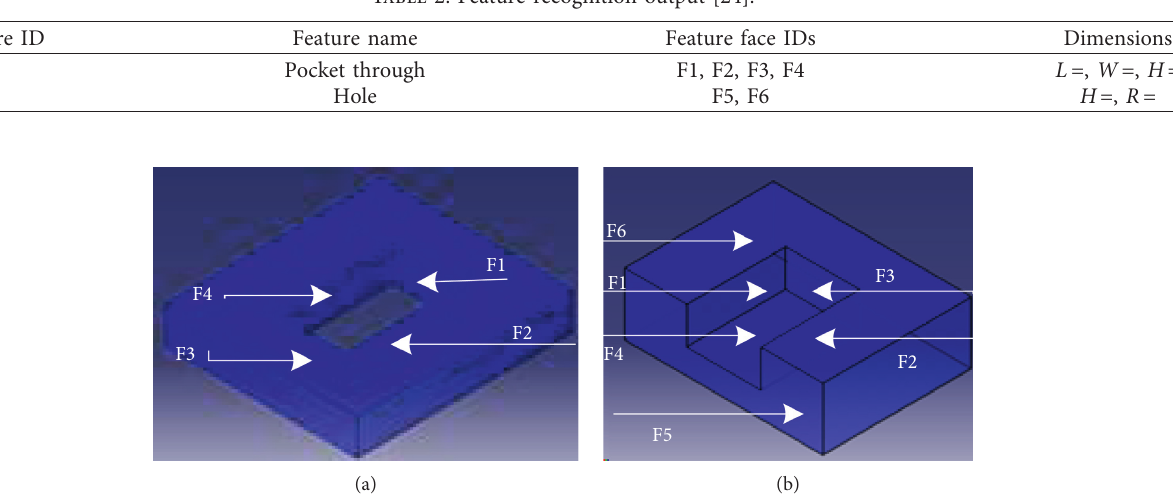
Figure 2: Different faces in features: (a) pocket through; (b) slot blind